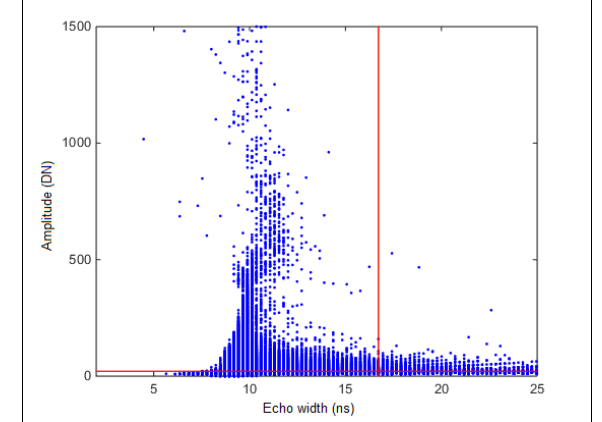
Figure 10. Vienna dataset: Scatterplot of Echo Width versus Amplitude for the first-of-many echoes. The red horizontal line separates the weak (66.6%) from the strong echoes (“highest third”). The vertical line shows the maximum echo width EW max which is the EW at the 99% quantile of the strong